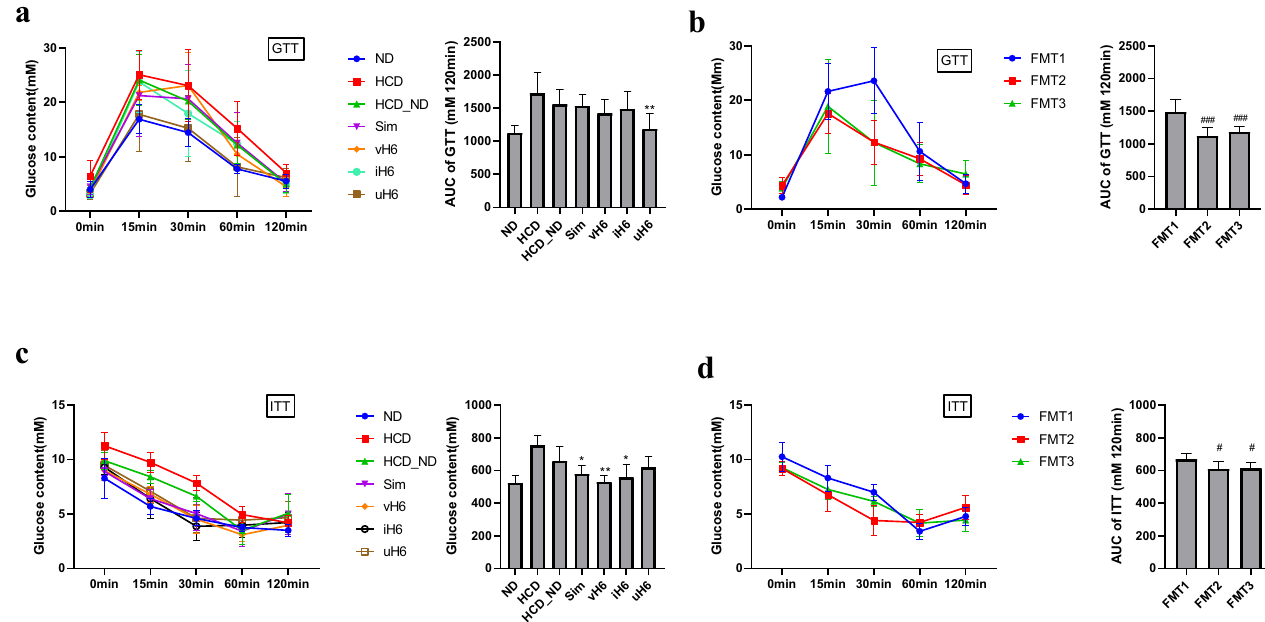
Fig. 3 Effects of v/i/uH6 and FMT on glucose tolerance test (GTT) and insulin resistance test (ITT) in hypercholesterolemic mice. a , b GTT: mice fasted overnight were injected with glucose (2 mg/kg) intraperitoneally. Blood glucose was determined at 0, 15, 30, 60, and 120 min then. c , d ITT: mice fasted for 4 h were injected with insulin (0.75 U/kg). Blood glucose was determined at 0, 15, 30, 60, and 120 min then. AUC value was calculated. Data are presented as the mean ± SEM ( n = 8). * P < 0.05, ** P < 0.01vs. control HCD_ND; # P < 0.05, ## P < 0.01, ### P < 0.001 vs. control FMT1. HCD_ND refers to the group of hypercholesterolemia model mice; v/i/uH6 refers to viable (vH6), heat-inactivated (iH6), and ultrasonically-lysed (uH6) bacteria cells; FMT1/2/3 refers to using feces from HCD_ND, Sim and vH6 groups,